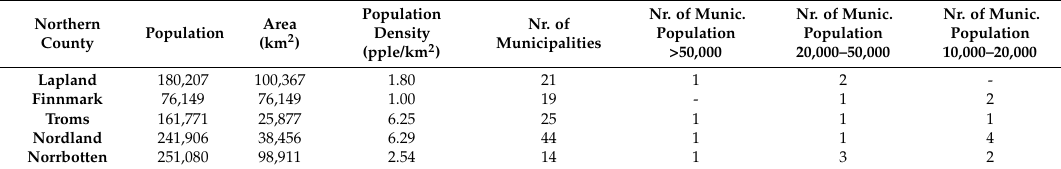
Table 9. Northern counties, population, area, nr of municipalities.